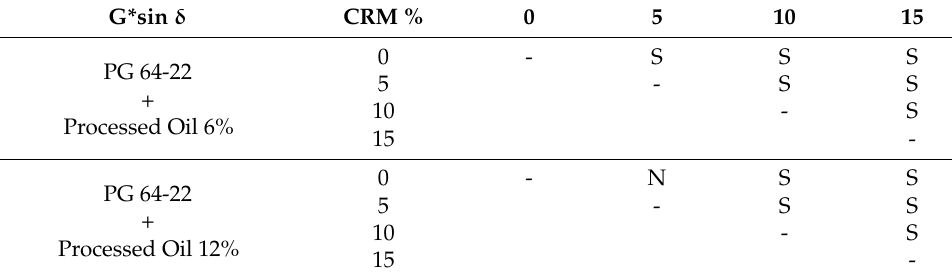
Figure 6. G* sin δ of RTFO + PAV aged PG 64-22 binder with processed oil as a function of CRM content at 25 °C. Table 8. Statistical analysis results ( α = 0.05) on the effect of CRM content on G*sin δ for PG 64-22 with processed oil after RTFO + PAV